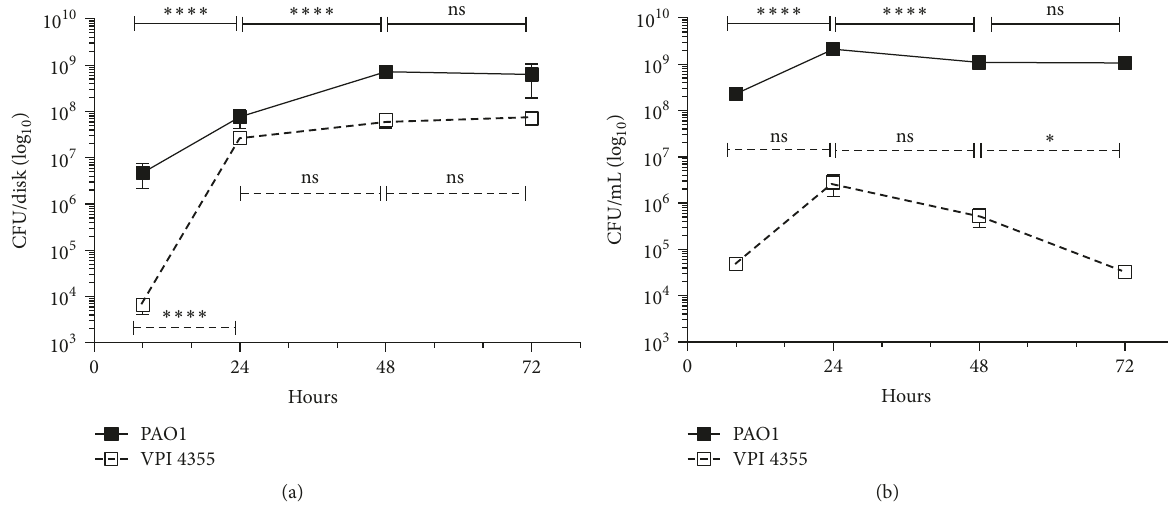
Figure 4: P. aeruginosa supports the growth of F. nucleatum in both planktonic and biofilm settings under aerobic conditions. Tubes containing 5 mL of BHI broth and a cellulose disk were inoculated with ∼ 10 6 CFU of P. aeruginosa and 10 2 CFU of F. nucleatum and incubated aerobically at 37 ∘ C for time indicated on graph. (a) The disks were removed and rinsed to remove planktonic bacteria, and the numbers of CFU in the biofilm (CFU/disk) were determined. (b) The numbers of planktonic bacteria (CFU/mL) were also determined. Values in (a) and (b) represent the means of three independent experiments ± SEM; ∗ 𝑃 < 0.05 ; ∗∗∗∗ 𝑃 < 0.0001 ; ns, no significant change.